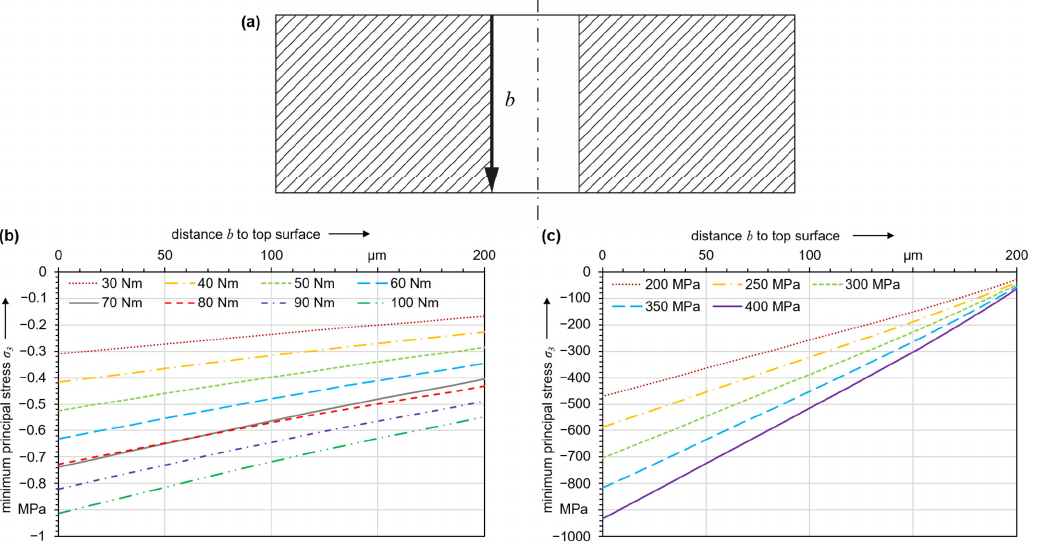
Figure 11. Minimum principal stress ( a ) inside the orifice bore along path b at ( b ) different tightening torques without pressurization and ( c ) different operating pressures after mounting the orifice with a tightening torque of 70 Nm.